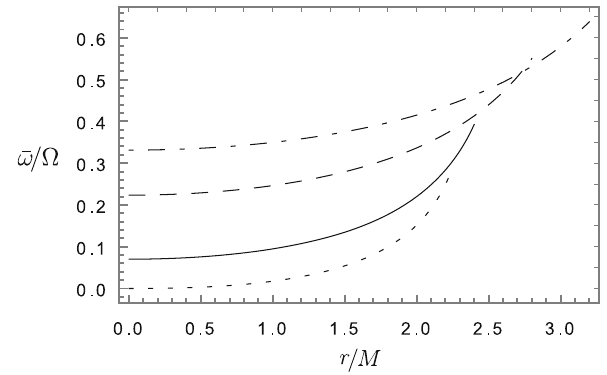
Fig. 4 Numerical solution for ¯ ω scaled by (cid:17) for R / M = 2 . 25 (dotted line), R / M = 2 . 4 (solid line), R / M = 2 . 8 (dashed line) and R / M